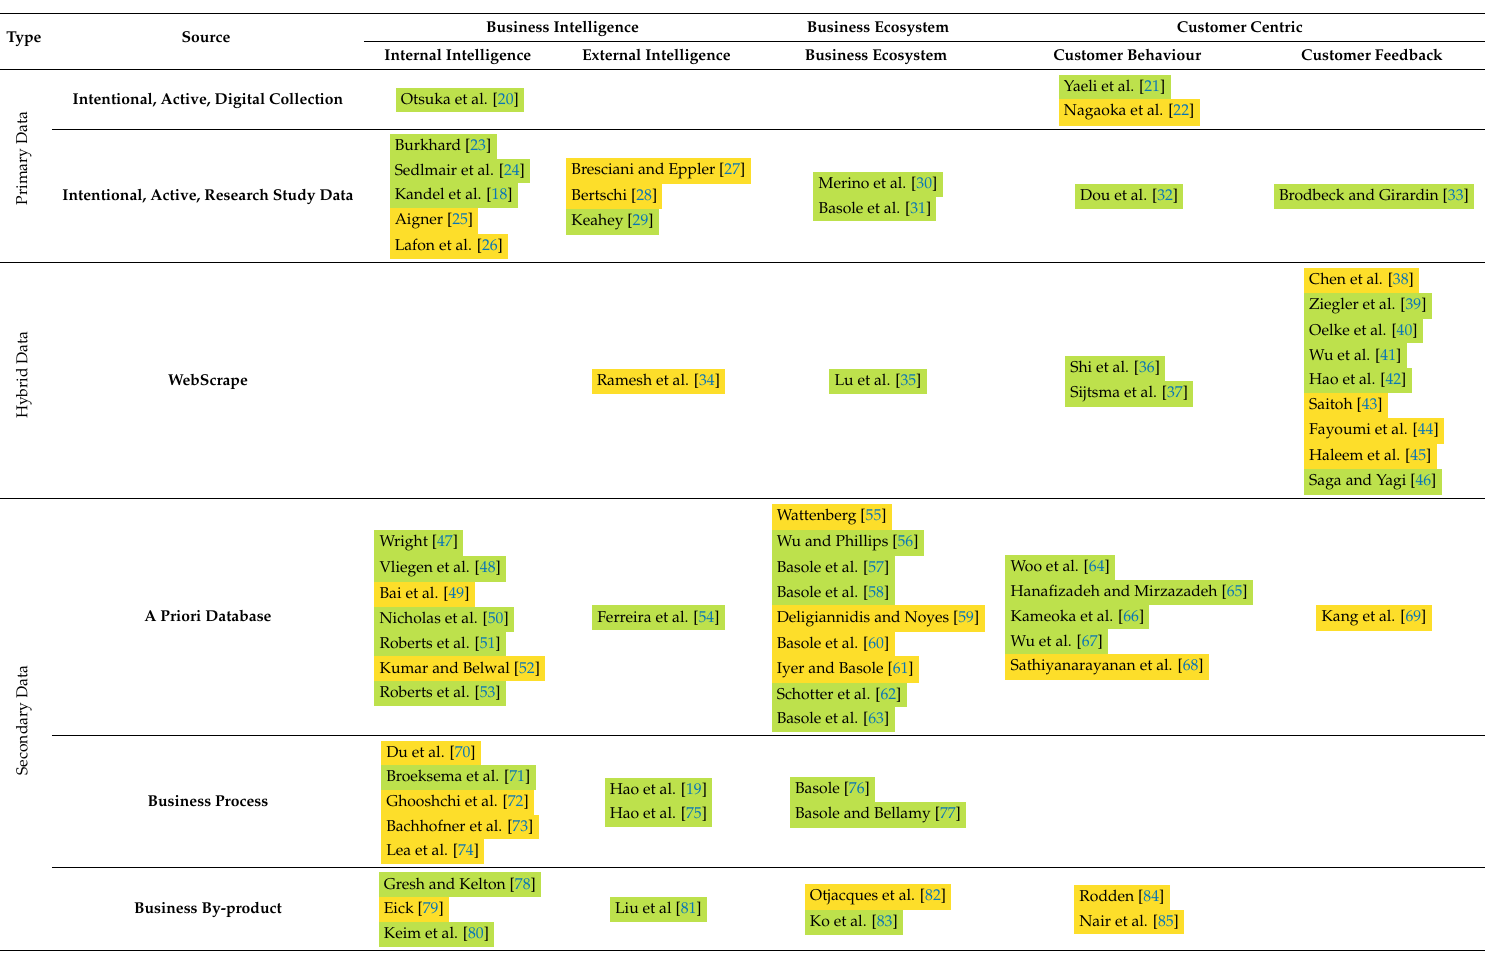
Table 1. This table shows our sub-classification based on data source. Divided into primary, secondary, and hybrid, the source shows the origin of data behind the research. Papers labelled in yellow are not summarised in detail due to space limitations but are still cited to be comprehensive. Papers labelled in green are summarised in the